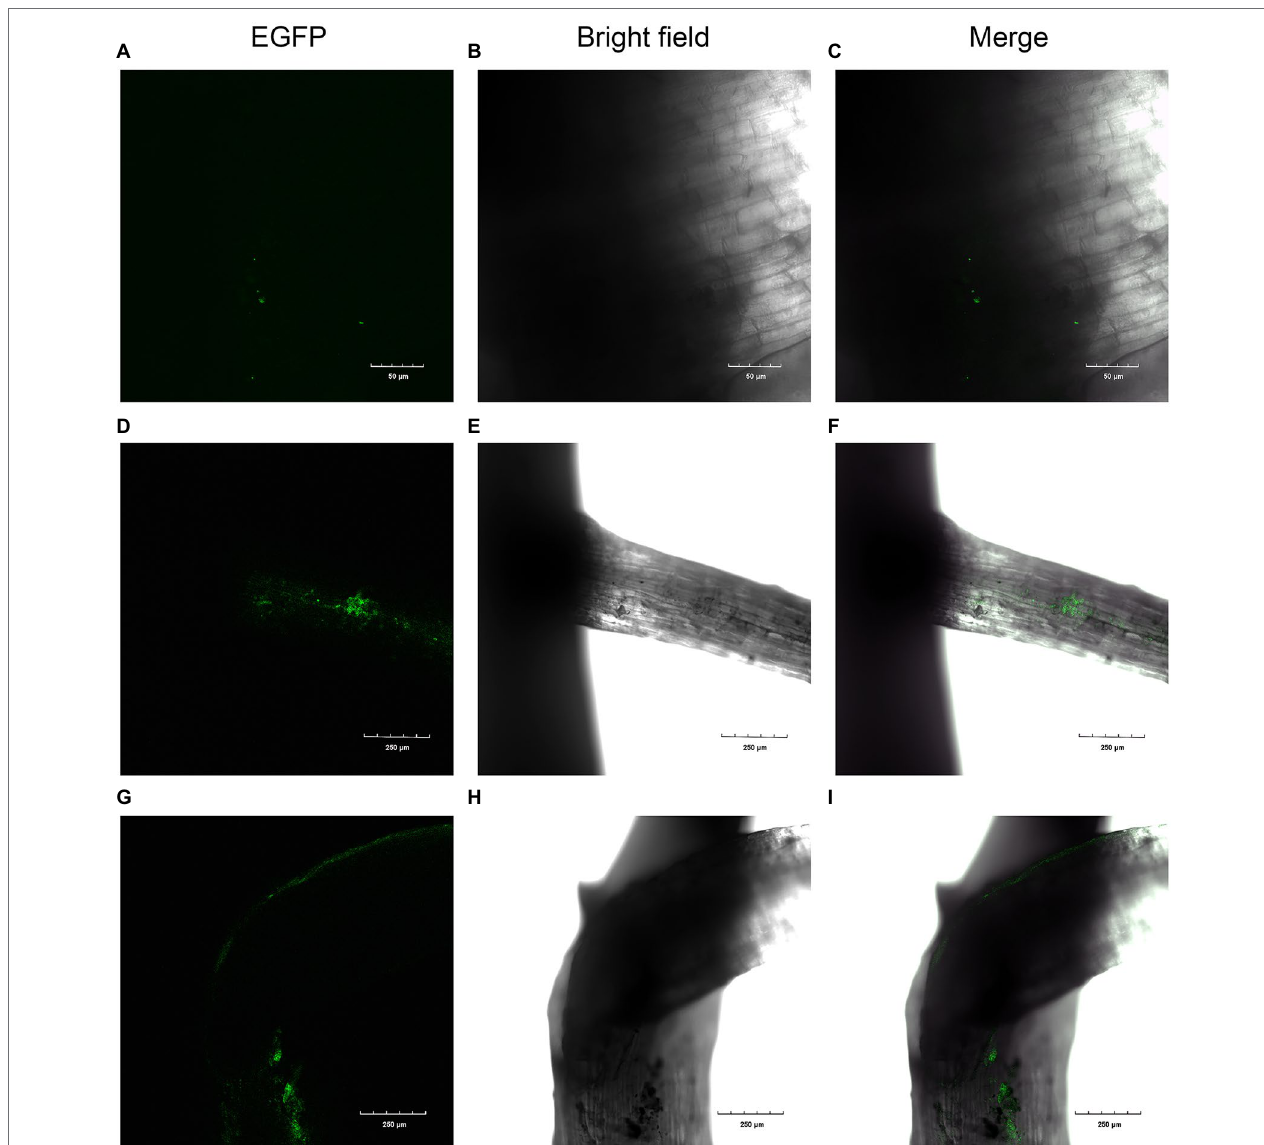
FIGURE 6 | Colonization of cotton roots by EGFP-labeled XN-04. Colonization after (A , B , and C) 2 days; (D , E , and F) 4 days; and (G , H , and I) 7